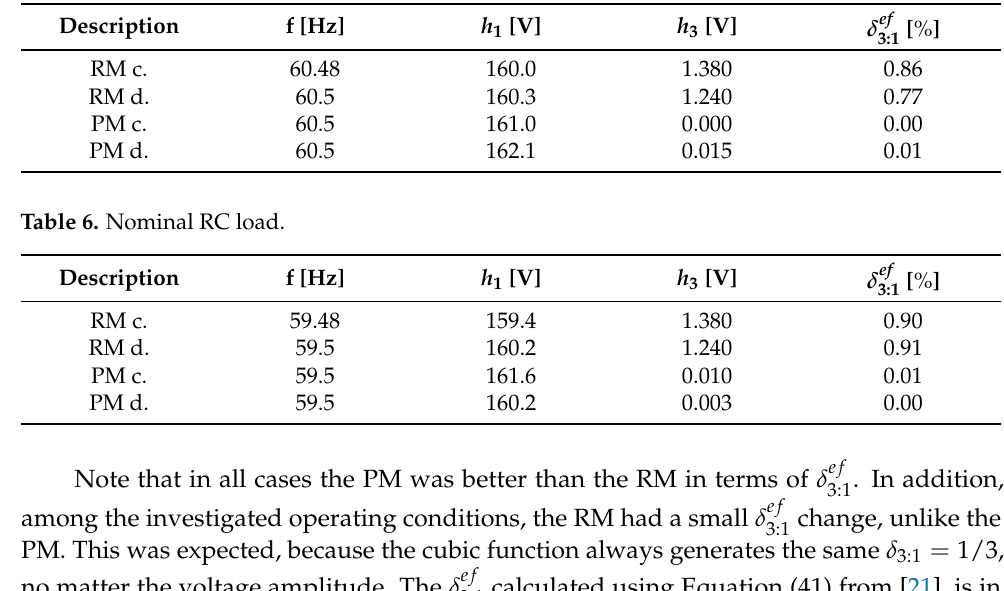
Table 5. Nominal RL load.